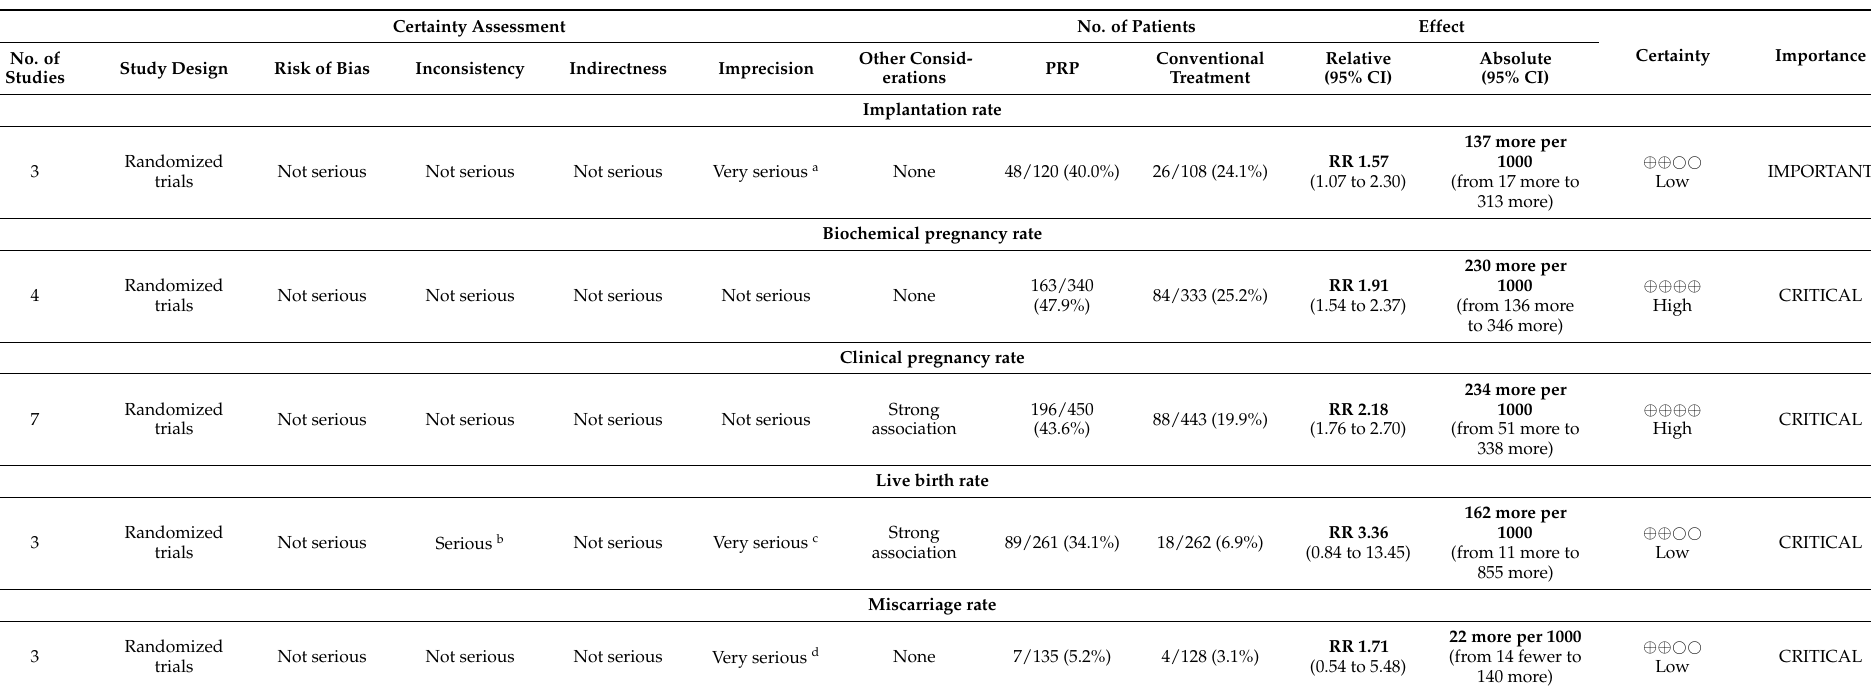
Table 3. Summary of the quality assessment by GRADE approach of outcomes included in the meta-analysis of repeated implantation failure patients. Certainty